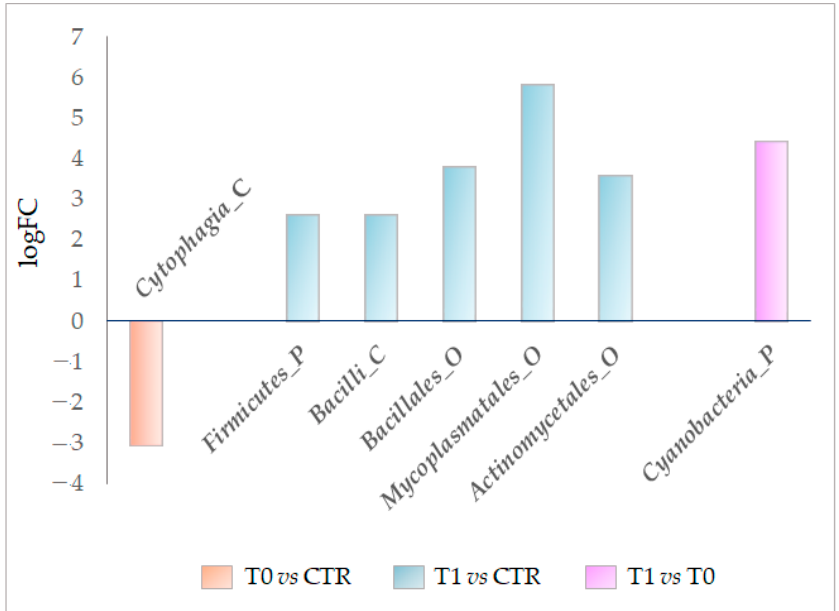
Figure 6 . Taxa di ff erentially modulated between the compared microbiotas (DESeq2 analysis, p - Figure 6. Taxa differentially modulated between the compared microbiotas (DESeq2 analysis, p -value, value, and FDR ≤ 0.05). After the underscore, the capital le tt er P, C, and O stand for phylum, class, and FDR ≤ 0.05). After the underscore, the capital letter P, C, and O stand for phylum, class, and and order, respectively. order,